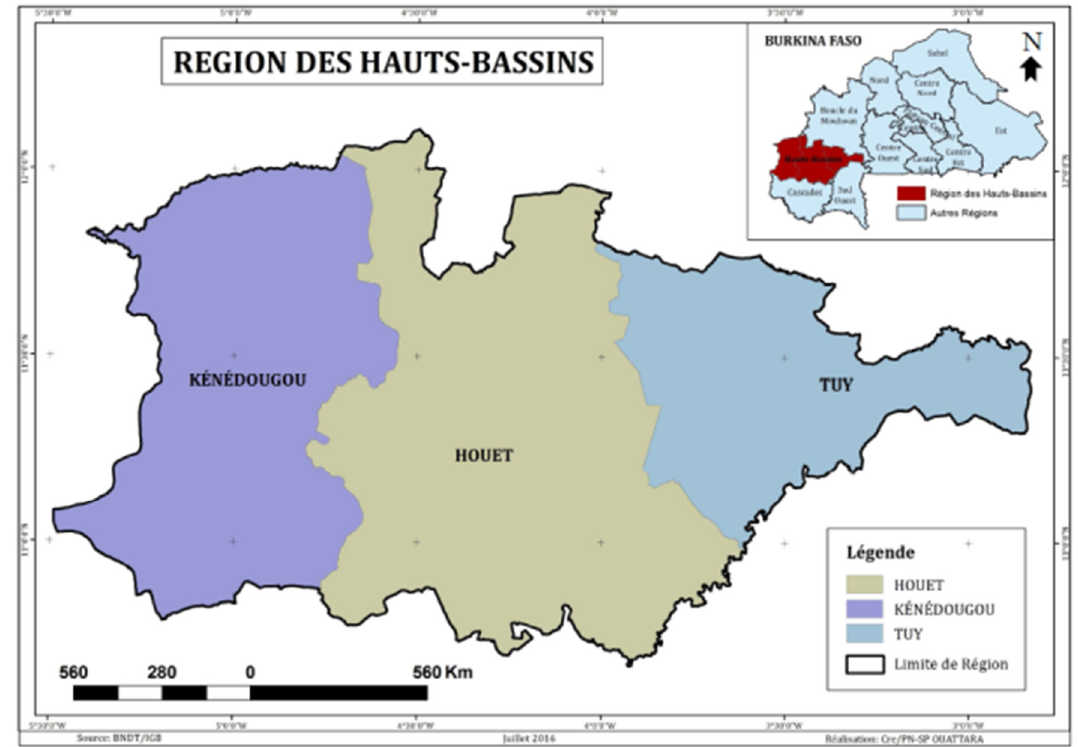
Figure 1. Study area localization (Hauts Bassins region of Burkina Faso).